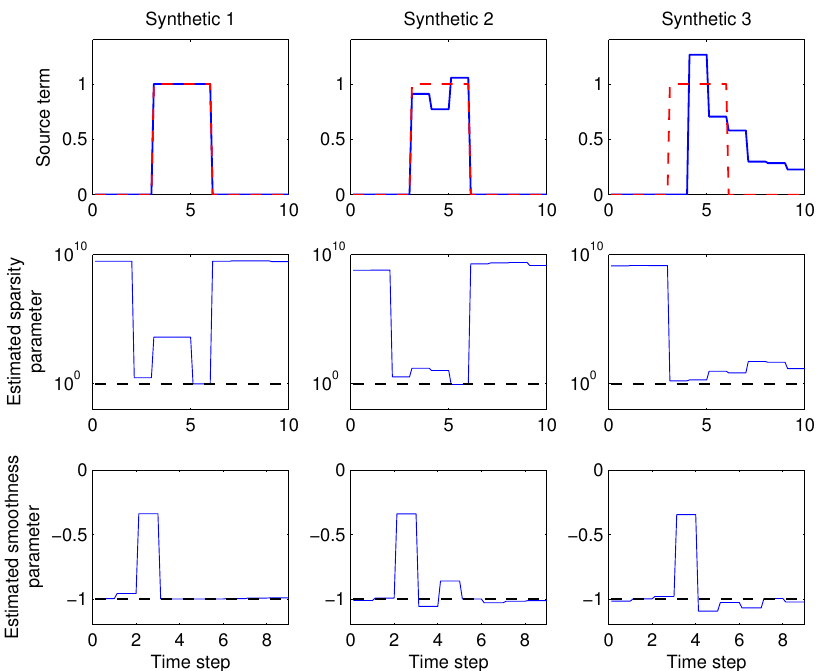
Figure 2. The results of the LS-APC algorithm on synthetically generated dataset with different levels of noise degradation (increasing from ) , where c k = 0 for the set Synthetic 1, c k = 0 . 4 for the set Synthetic 2, and c k = 0 . 8 for the set Synthetic 3). In left to right; e j = N ( 0 ,c 2 k the top panel, the true source term is given by the red line while the estimated source term is given by the blue line. The estimated sparsity parameters, vectors (cid:104) υ (cid:105) , are given in the middle panel using full line while prior values are given using dashed black lines and the estimated smoothness parameters, vectors (cid:104) l (cid:105) , are given in the bottom panel while prior values are given using dashed black